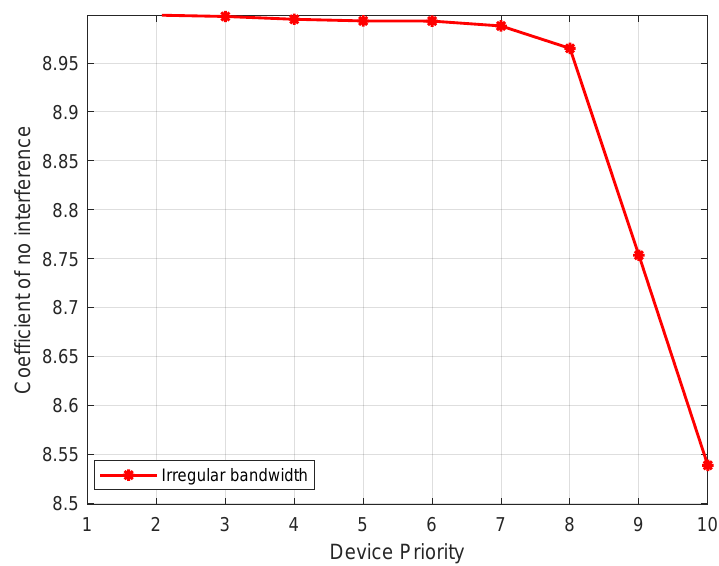
Figure 6. Experimental curve of priority function